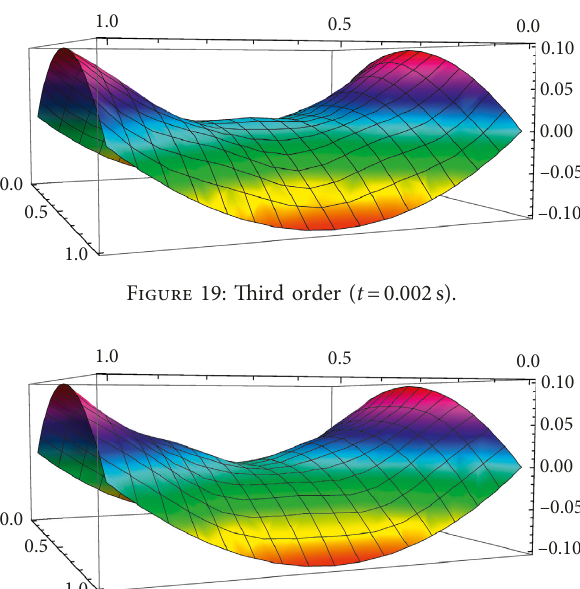
Figure 15: First order ( t � 0.002s).